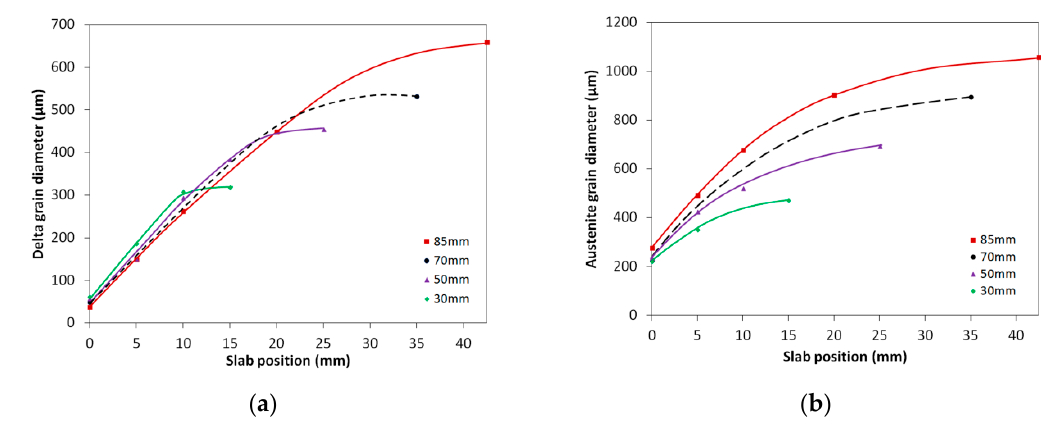
Figure 8. ( a ) The predicted delta grain size of 30, 50, 70, and 85 mm slabs as a function of slab position just before the onset of the delta to gamma transformation; ( b ) the predicted austenite grain size of 85, 70, 50, and 30 mm slabs as a function of slab position when the slab is about to enter the homogenization furnace.